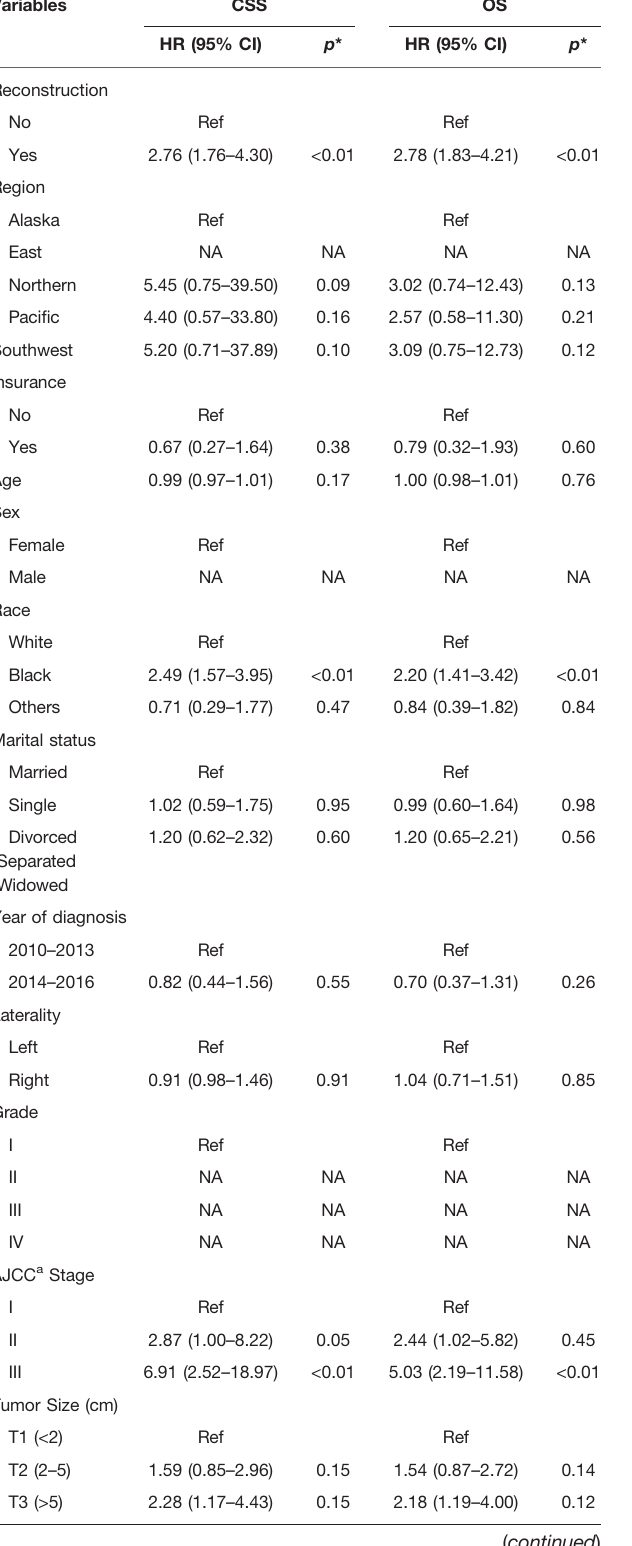
TABLE 2 | Univariable Cox proportional hazard regression model of cancer- speci fi c survival and overall survival.